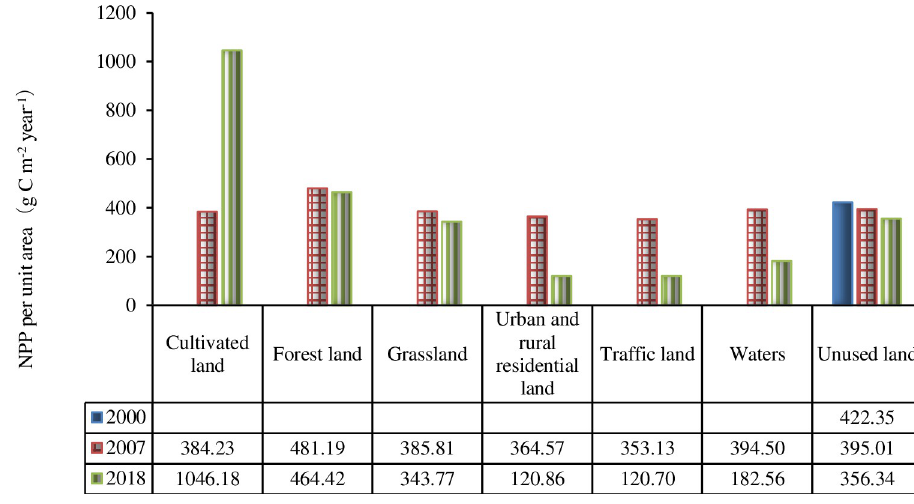
Fig 5. NPP values per unit area of different land use types in the study area from 2000 to